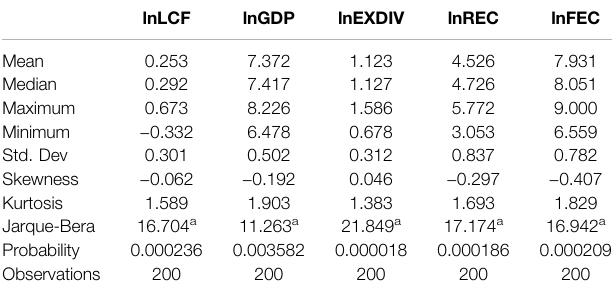
TABLE 1 | Descriptive